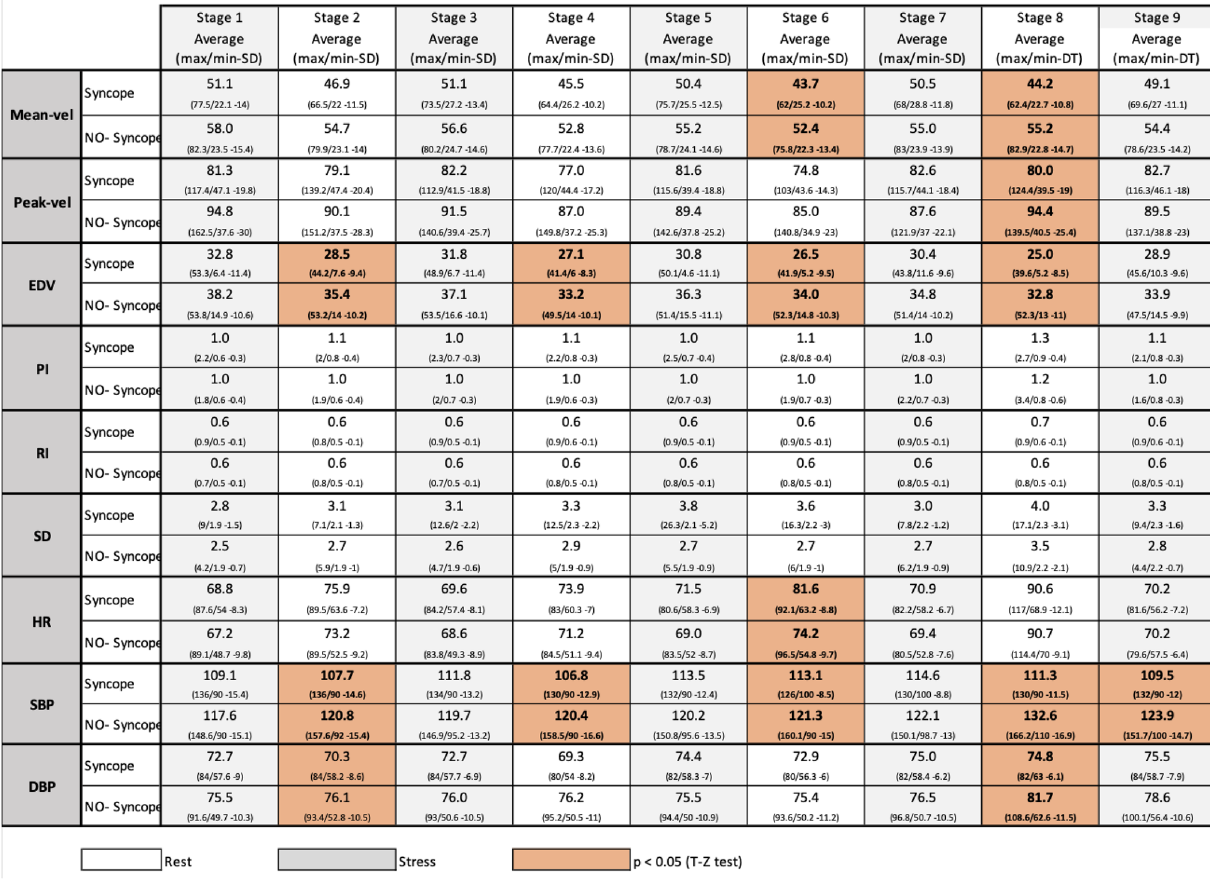
Table 1. Difference of the mean for each subject in each of the nine stages (Sincope and Non-Sincope groups). SBP systolic blood pressure, DBP diastolic blood pressure, MBP mean blood pressure, Peak-vel . systolic velocity of the MCA, Mean-vel . mean velocity of MCA, EDV end diastolic velocity of the MCA, PI pulsatility index, RI resistance index, SD systolic/diastolic velocity